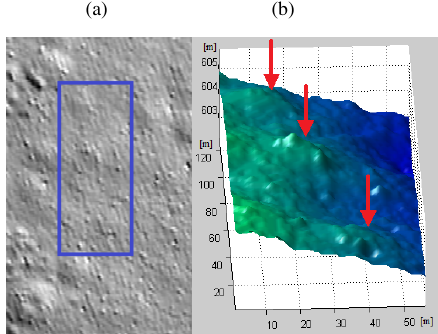
Figure 5. Visibility of 3 tumuli in the shaded relief model and in the original